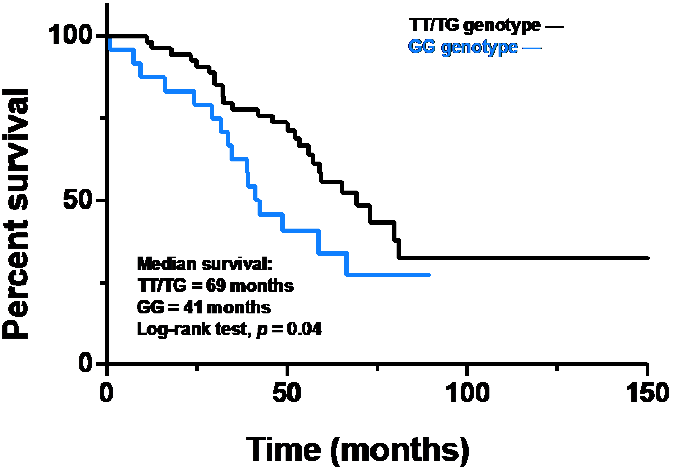
Figure 3. Survival of the study population categorized in TT/TG genotype or GG genotype. Survival analysis of TT/TG and GG genotype patients. The black line represents survival in the TT/TG group and the blue line represents survival in the GG group. Kaplan Meier analysis was used with a log-rank test (HR 0.52, 95% CI 0.28–0.98; p = 0.04).